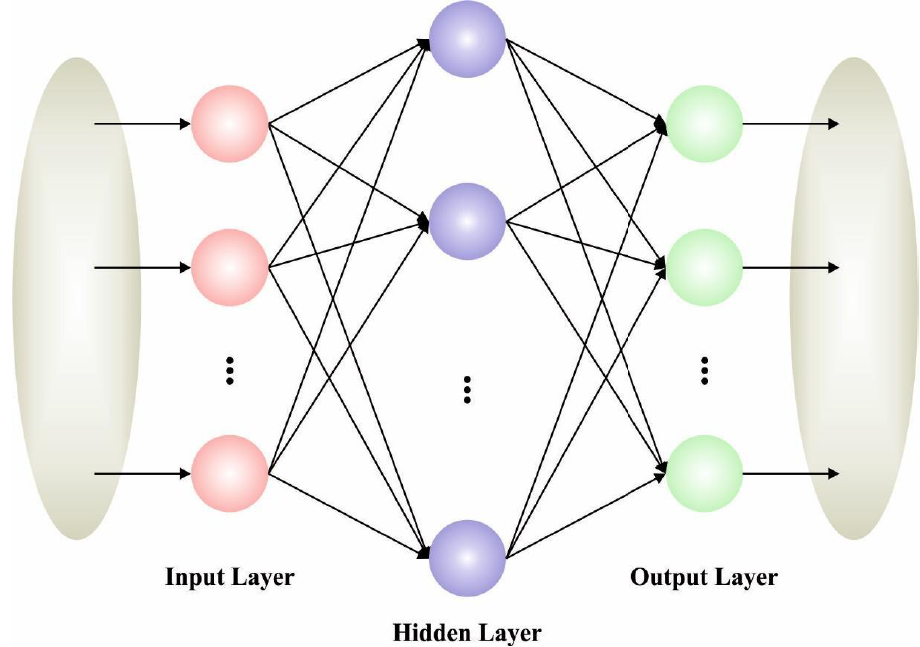
Figure 2. ELM structure.